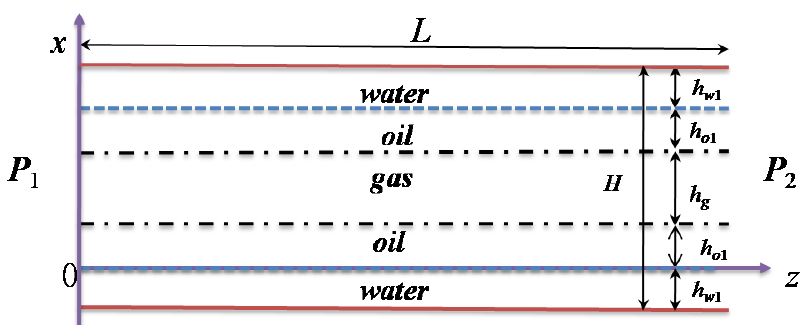
Figure 1—Proposed fracture model used in the mathematical model. For a perfectly smooth fracture placed horizontally with negligible gravity and buoyancy